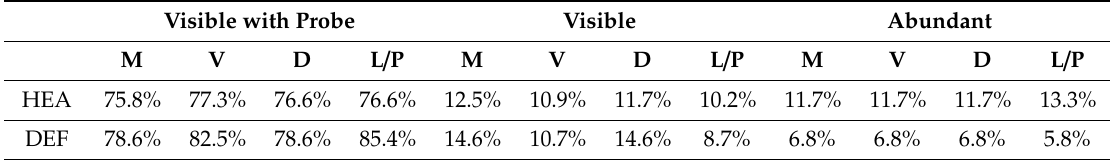
Table 2. Modified Plaque Index, 6 months.